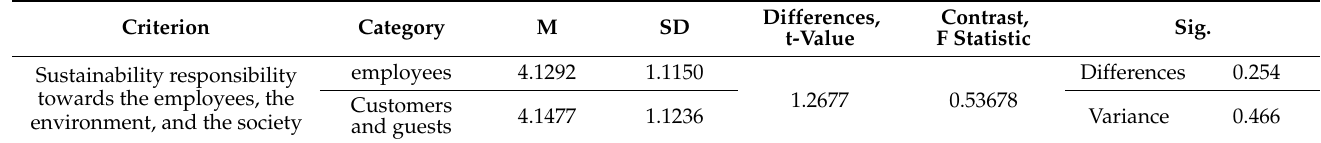
Table 3. Test of statistical differences about the application of sustainability responsibility criteria for the environment and society from the employees’ and customers’